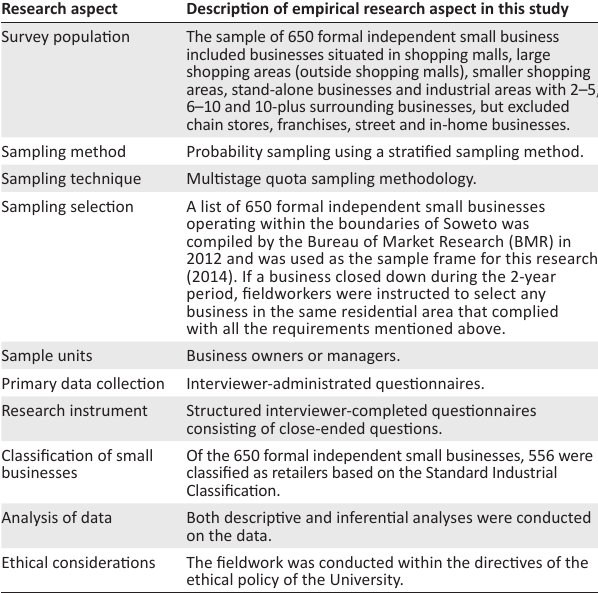
TABLE 1: Research methodology used to conduct the 2014 Soweto